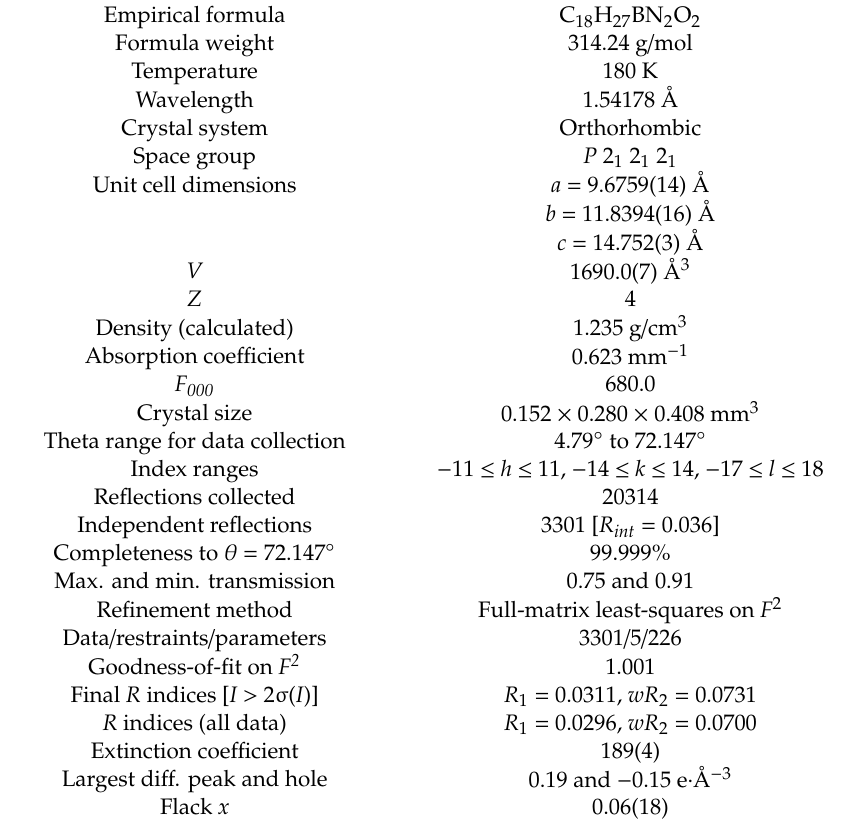
Table 1. Crystallographic data of the structures.